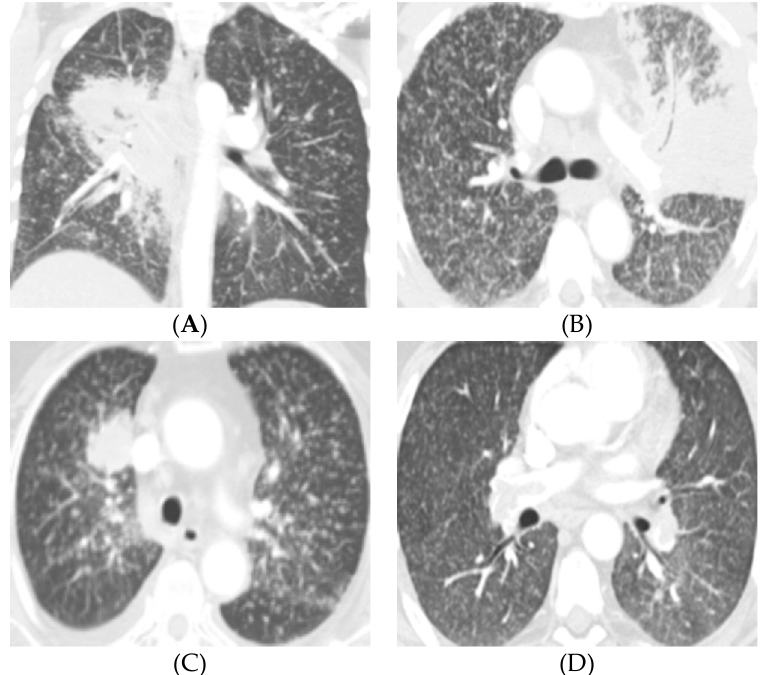
Figure 1. Four patients with EGFR -mutated lung cancers and diffuse lung metastases. ( A ) 44-year-old female never-smoker presents with a central right hilar mass with mediastinal and right hilar lymphadenopathy and innumerable 2–3 mm pulmonary nodules bilaterally. Patient was subsequently diagnosed with non-small cell lung cancer (NSCLC) with EGFR exon 19 mutation. Note the air bronchograms in the primary tumor, a feature also described in EGFR -mutated NSCLC. ( B ) 66-year-old male never-smoker presents with a consolidative mass in the left upper lobe and lingula with miliary-like pattern of di ff use 2–3 mm pulmonary nodules bilaterally and mediastinal and left hilar lymphadenopathy. This patient was found to have NSCLC with EGFR exon 21 mutation. Again, note the air bronchogram in the primary tumor. ( C ) 74-year-old female never-smoker presenting with a dominant right upper lobe mass and di ff use innumerable 2–3 mm nodules bilaterally. Patient had an EGFR exon 19 mutation. ( D ) 61-year-old male never-smoker presents with di ff use 2–3 mm lung nodules with a dominant 2.3 cm left lower lobe spiculated nodule (not shown), which was positive for EGFR exon 19